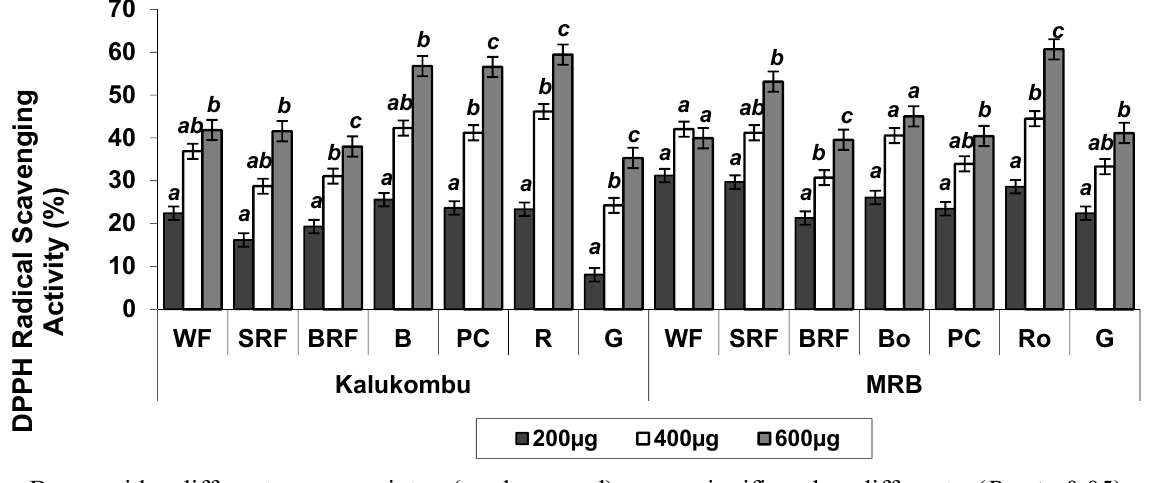
Bars with different superscripts (a, b, c, d) are significantly different ( P ≤